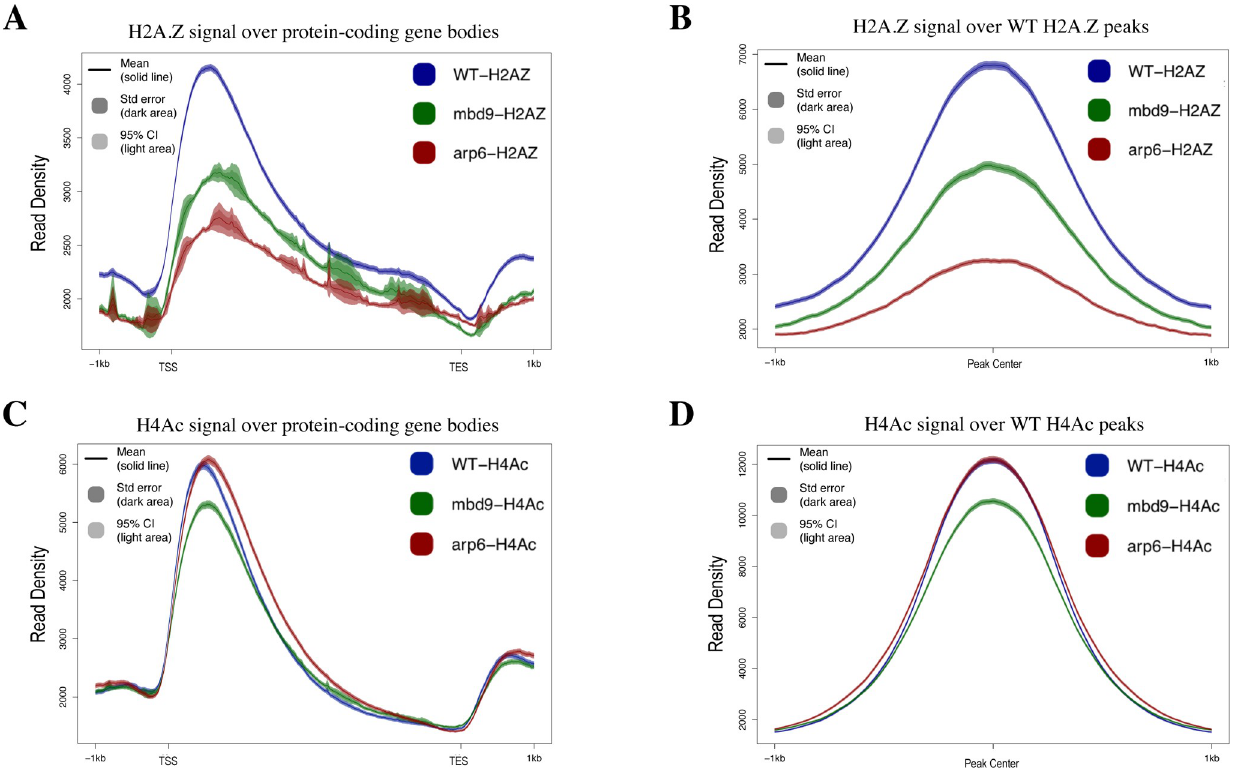
Fig 2. The effects of MBD9 on H2A.Z incorporation and H4 acetylation. All ChIP-seq profiles of WT (shown in blue), mbd9-1 (shown in green), and arp6-1 (shown in red) were produced using SeqPlots. Standard error is represented as shading around the solid line of the mean signal. (A) Average ChIP- seq H2A.Z profiles plotted over gene body coordinates for all protein-coding Arabidopsis genes, from the transcript start site (TSS) to the transcript end site (TES). (B) H2A.Z signal for each genotype over reproducible H2A.Z-enriched regions from WT plants. (C) Average ChIP-seq H4Ac profiles plotted across gene bodies. (D) H4Ac signals over reproducible H4Ac-enriched regions from WT plants.